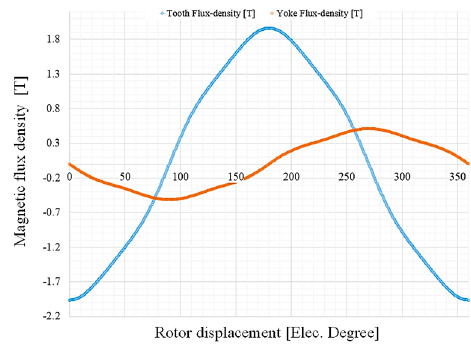
Figure 3. Magnetic flux density distribution using Equations (17) and (18) for tooth and yoke of stator.